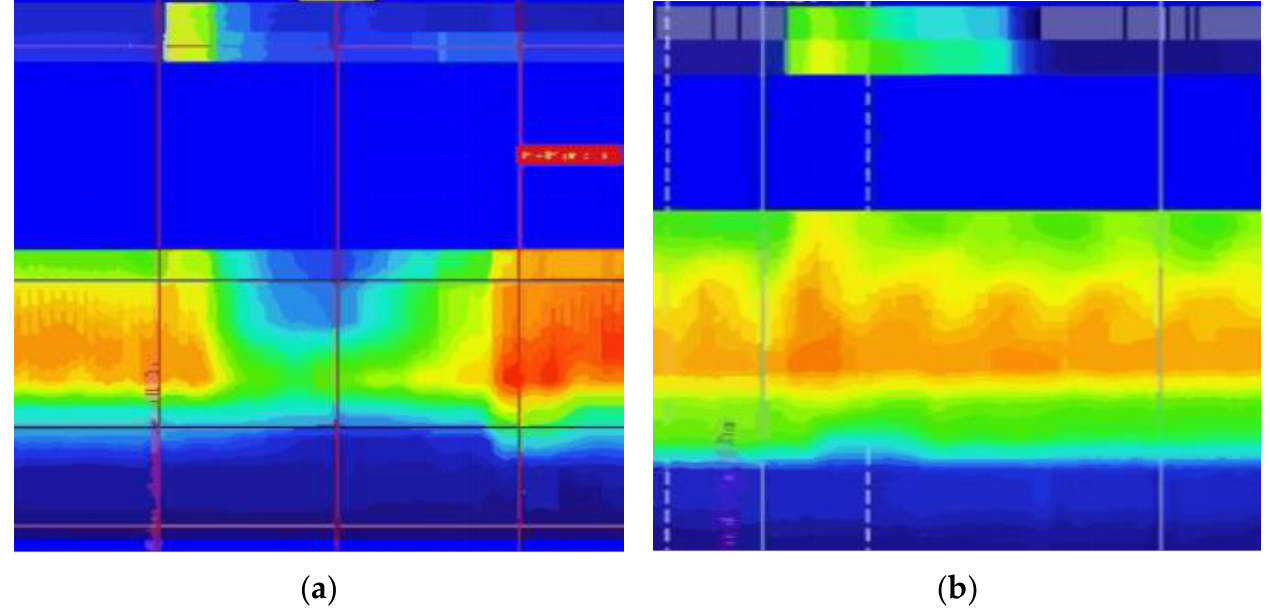
Figure 1. High-resolution anorectal manometry studies during balloon inflation. ( a ) Patients with rectoanal inhibitory reflex (RAIR) and ( b ) patients with rectoanal areflexia (RA). The upper part shows the pressure of the balloon inflation, and the lower part shows the effect on the anal canal. The pressure gradually displays from dark blue (lowest pressure = 0 mmHg) to red (highest pressure = 150 mmHg).